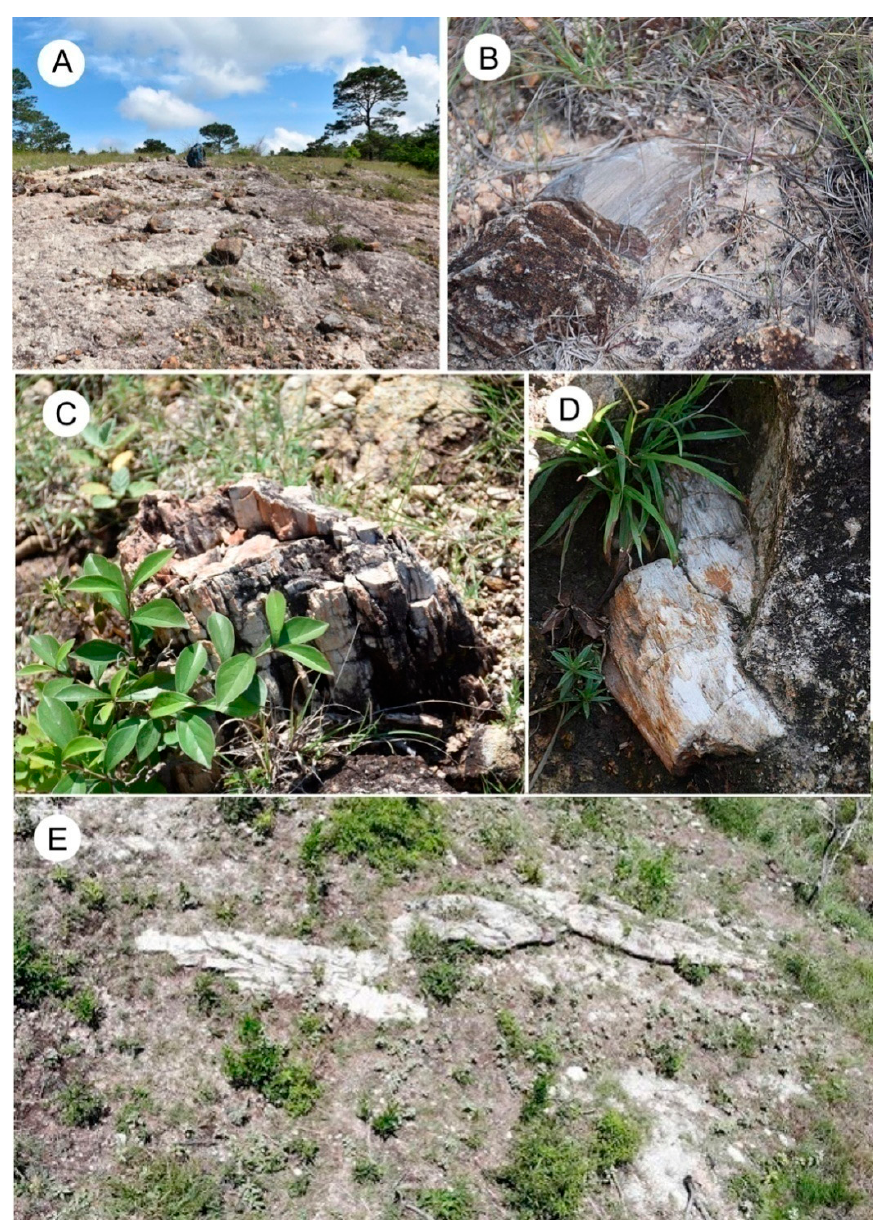
Figure 3. Field photos. ( A ) A rock outcrop at the Las Crucitas source with the highest concentration of petrified wood. ( B ) An example of a petrified wood fragment in place at Las Crucitas. ( C ) Petrified wood trunk at Salitre. ( D ) A petrified wood fragment enclosed by volcanic rock at Salitre. ( E ). A Y-shaped fossilized tree.